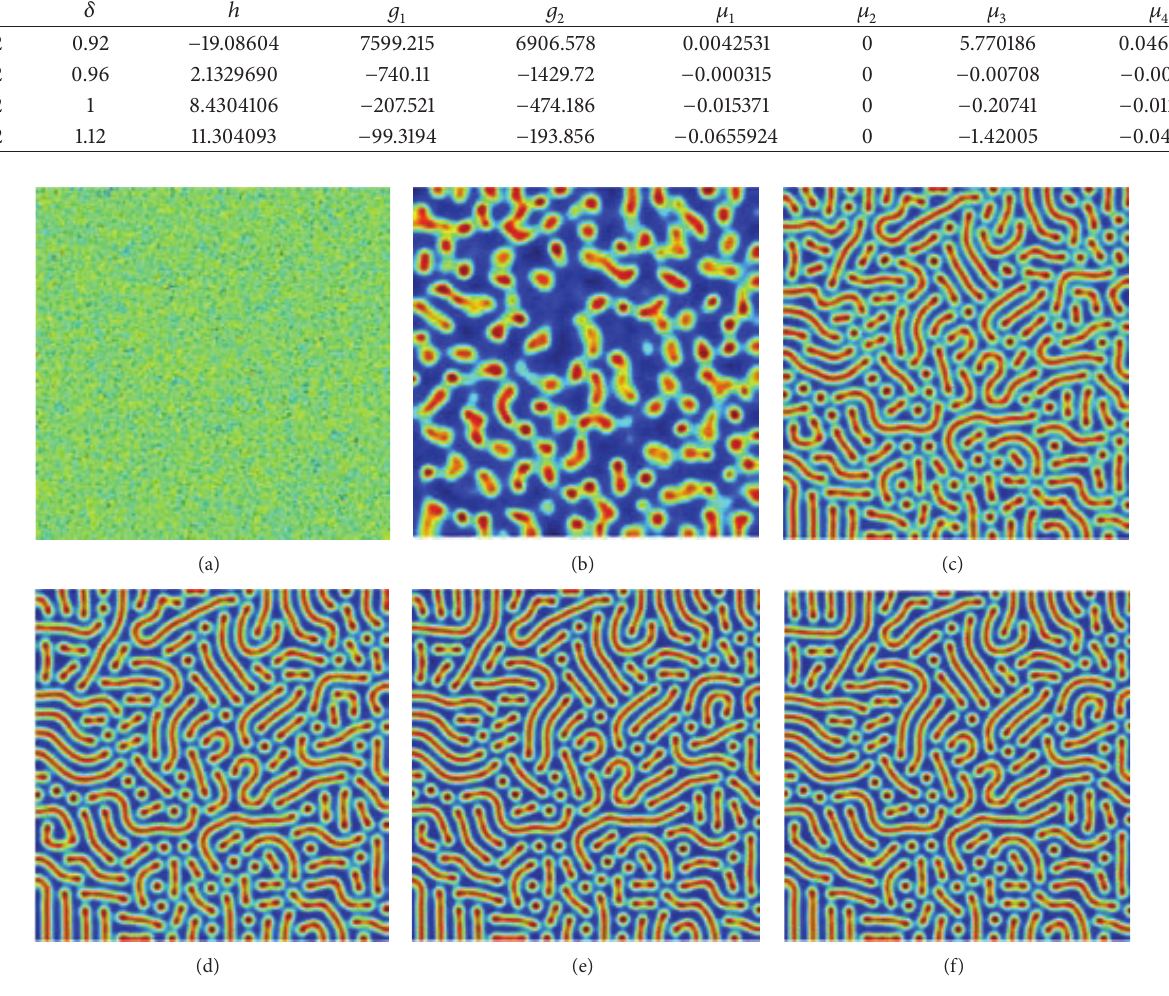
Figure 3: Spatial pattern of prey population at different time. Parameters set: 𝛾 = 1.5 , 𝜀 = 0.15 , and 𝛿 = 0.92 . (a) 𝑡 = 0 ; (b) 𝑡 = 100 ; (c) 𝑡 = 200 ; (d) 𝑡 = 500 ; (e) 𝑡 = 1000 ; and (f) 𝑡 = 2000